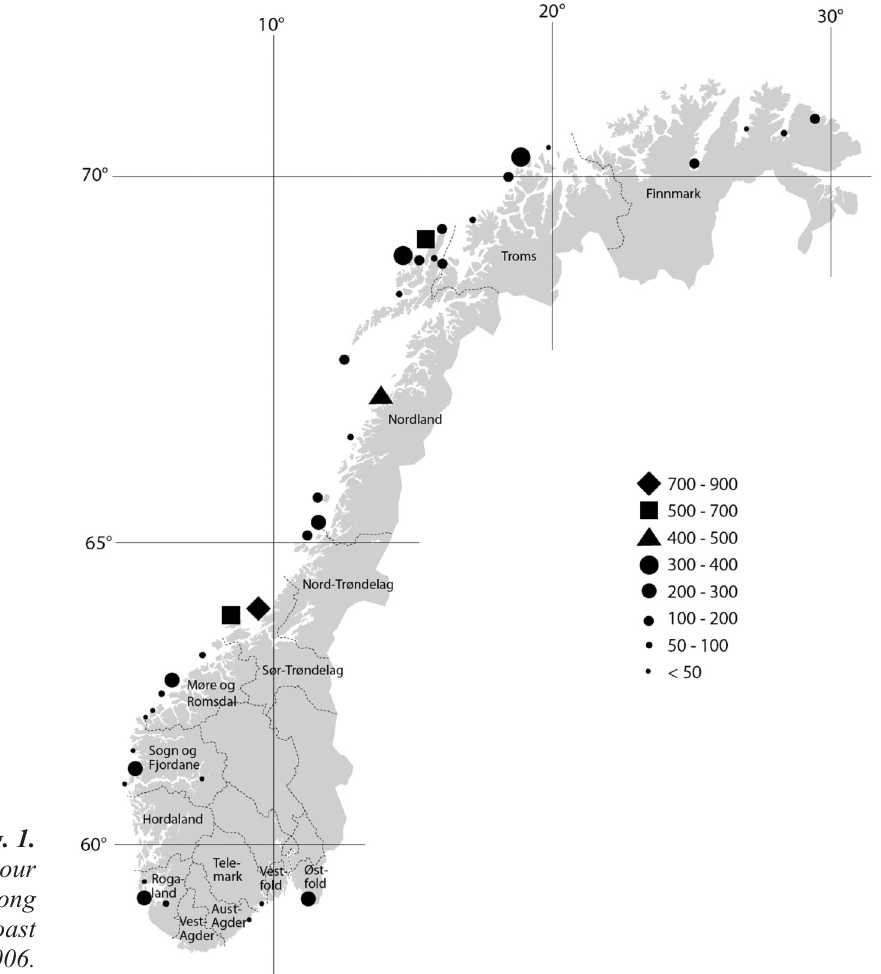
seals recorded along the Norwegian coast during